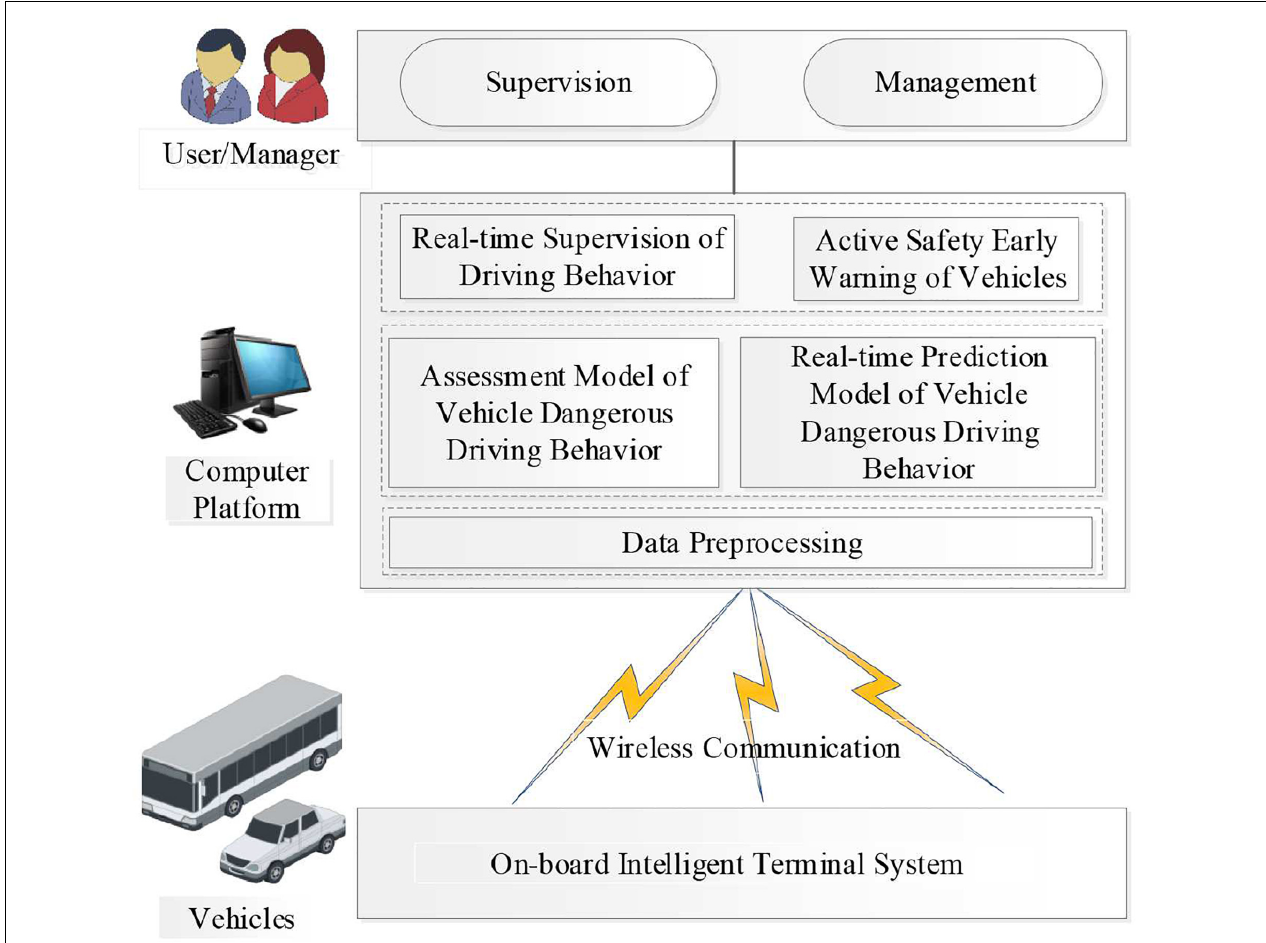
FIGURE 2 | Real-time vehicle attitude monitoring system for dangerous driving behavior